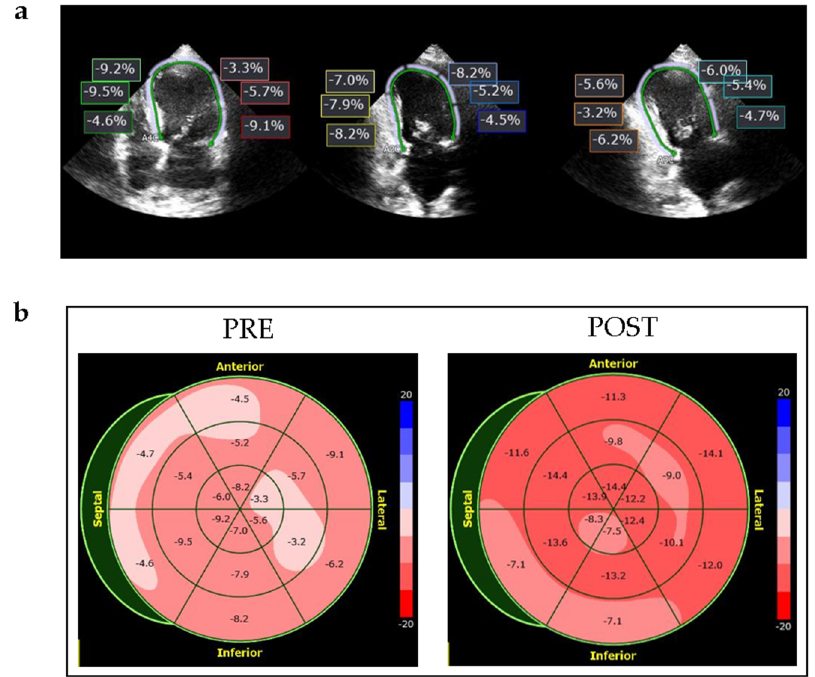
Figure 2. Left ventricular strain in a patient with tachycardic AF and reduced EF. ( a ) Two-dimensional echocardiographic images showing strain measures of the left ventricle before electrical cardioversion (ECV) in the apical four, three and two chamber view from left to right; ( b ) 18 segment bull’s eye plots of this patient before (pre) and after (post) ECV. AF: atrial fibrillation; EF: ejection